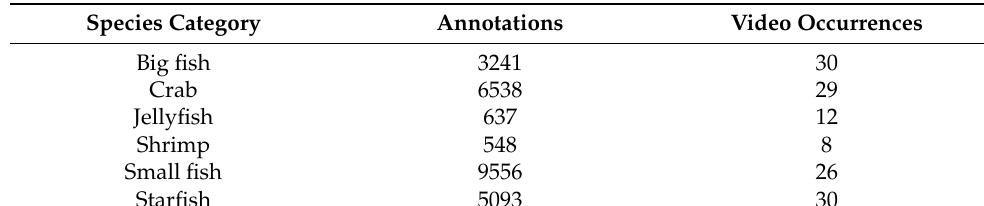
Table 1. Category annotation number of the brackish dataset.